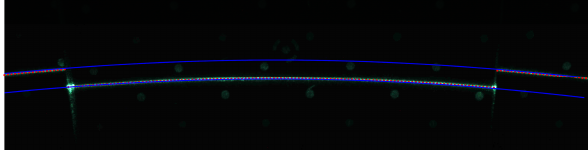
Figure 9: Laser line measurement in the image (detail) with LSM-based image measurements (red dots) and epipolar lines of the reference depths (blue lines).